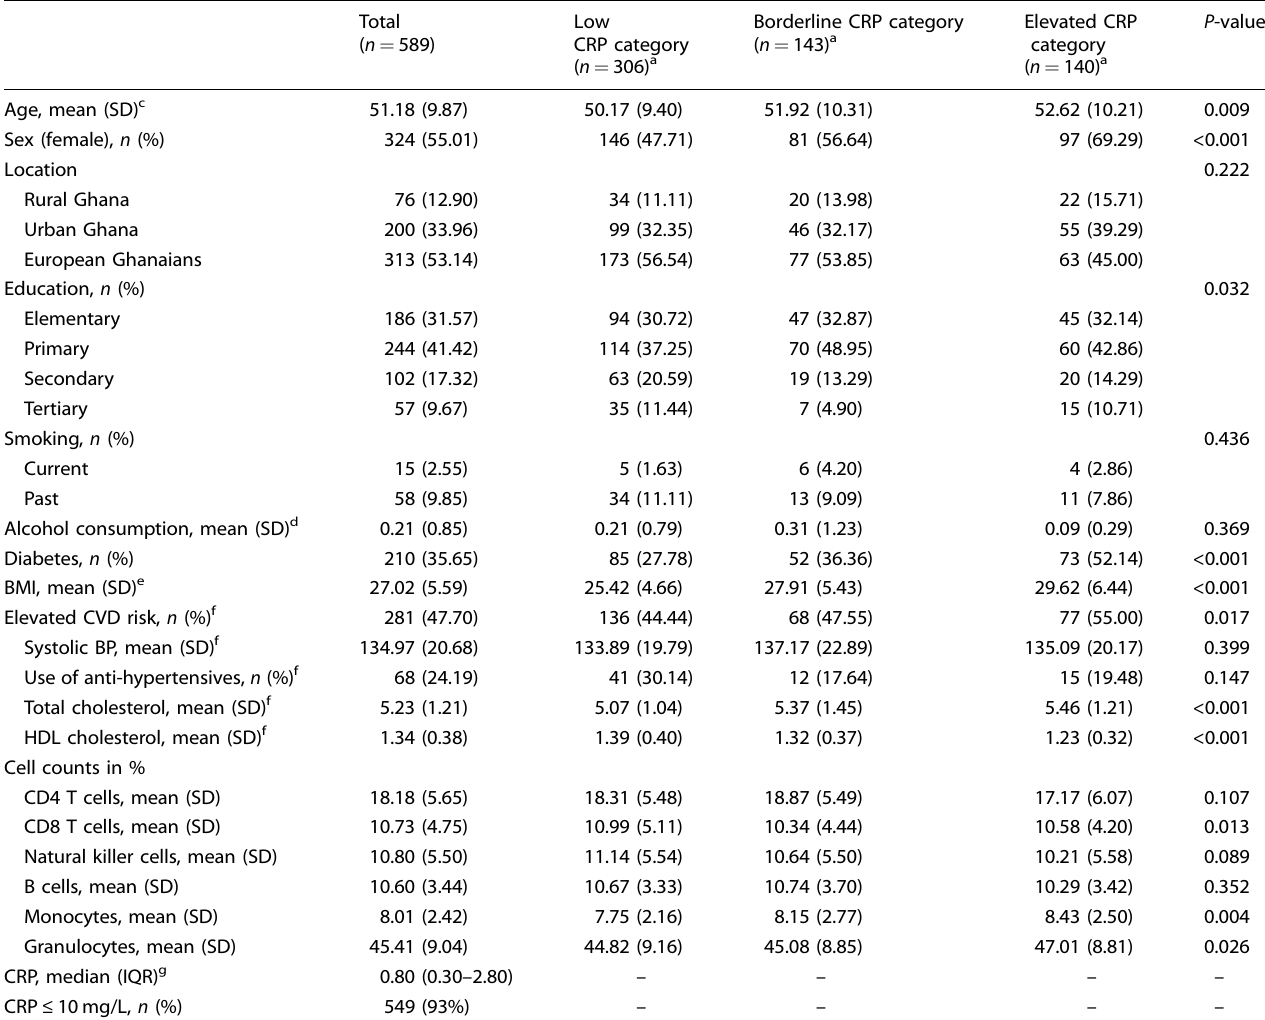
Table 1. Baseline characteristics of Ghanaian